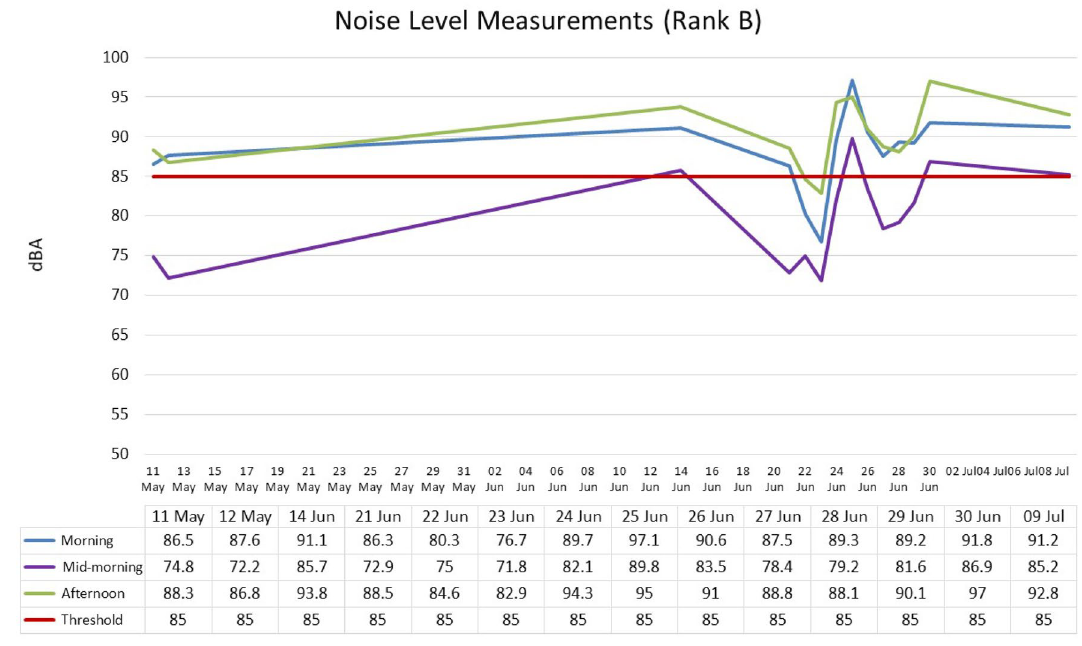
Figure 2. Noise level measurements: Rank B (Closed).